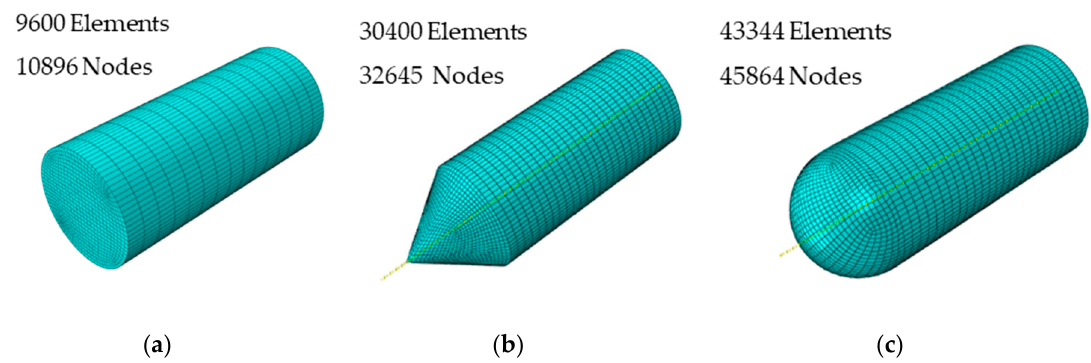
Figure 12. Mesh of the projectiles: ( a ) blunt, ( b ) conical, and ( c ) hemispherical.